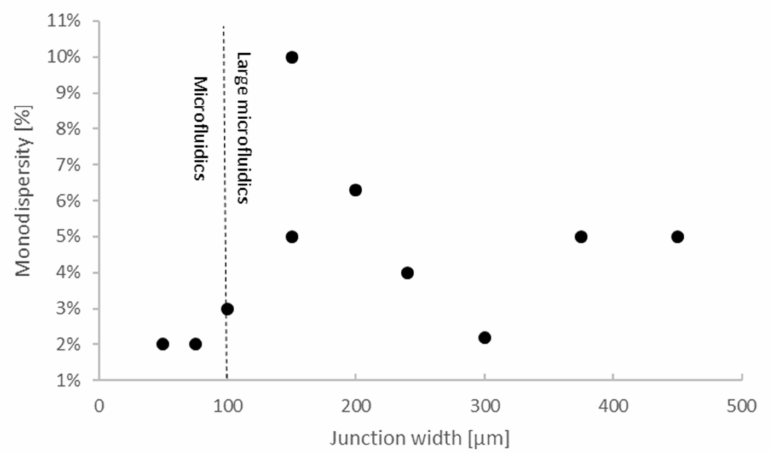
Figure 6. Most demonstrated 3DP droplet microfluidics were able to generate droplets with monodis- persities lower than 6%. Comparing the junction width and the reported monodispersities, we can see that most 3DP droplet generators were capable of generating droplets with ~5–6% monodispersities on average in the large microfluidics size domain. In the microfluidics size domain below a 100 µ m junction width, a monodispersity better than 3% was also